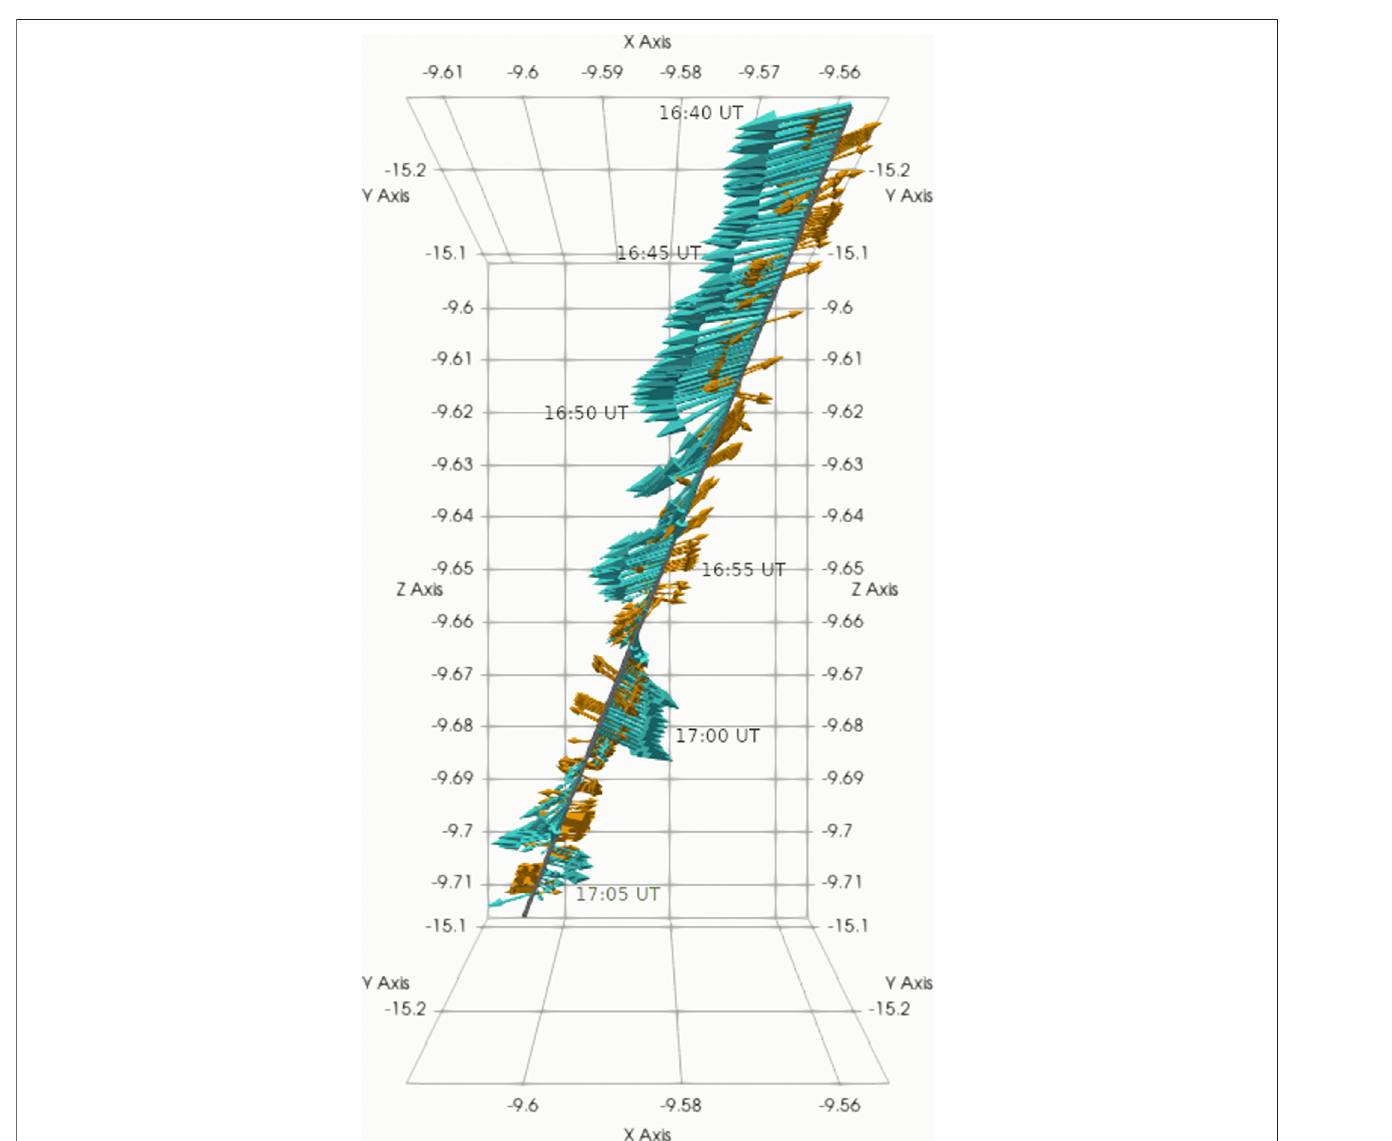
FIGURE 5 | SC 1 derived observations of the HT velocity vectors (cyan) and of the boundary normals (yellow) for the KHI event on July 3, 2007 are shown for the time frame of 1640 – 1705 UT.